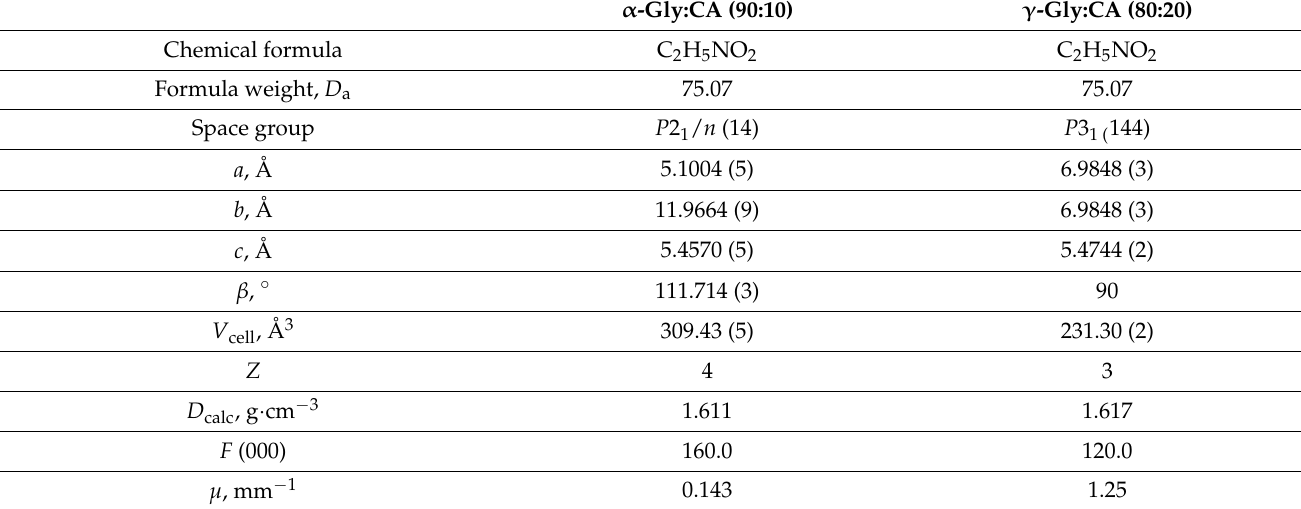
Table 1. Details of crystal data and structure refinement of α -Gly:CA (90:10) and γ -Gly:CA (80:20) single